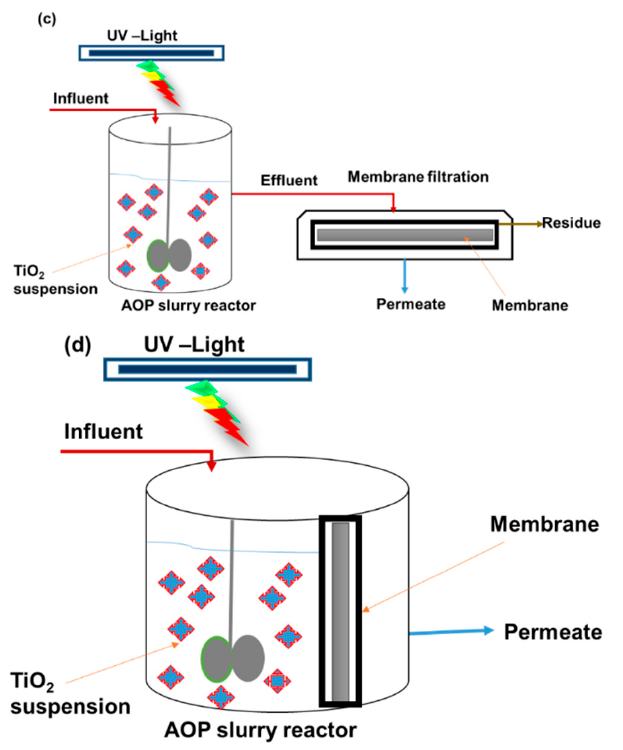
Figure 4. Schematic diagram of TiO 2 -based membrane reactor types: ( a ) a membrane inserted inside a photoreactor with internal walls coated with a photocatalyst such as TiO 2 , ( b ) a pure TiO 2 porous photocatalytic membrane, ( c ) a slurry photocatalytic reactor followed by a membrane filtration unit, and ( d ) an inorganic or polymeric membrane submerged in a slurry photocatalytic reactor; adapted from [18,26,32].